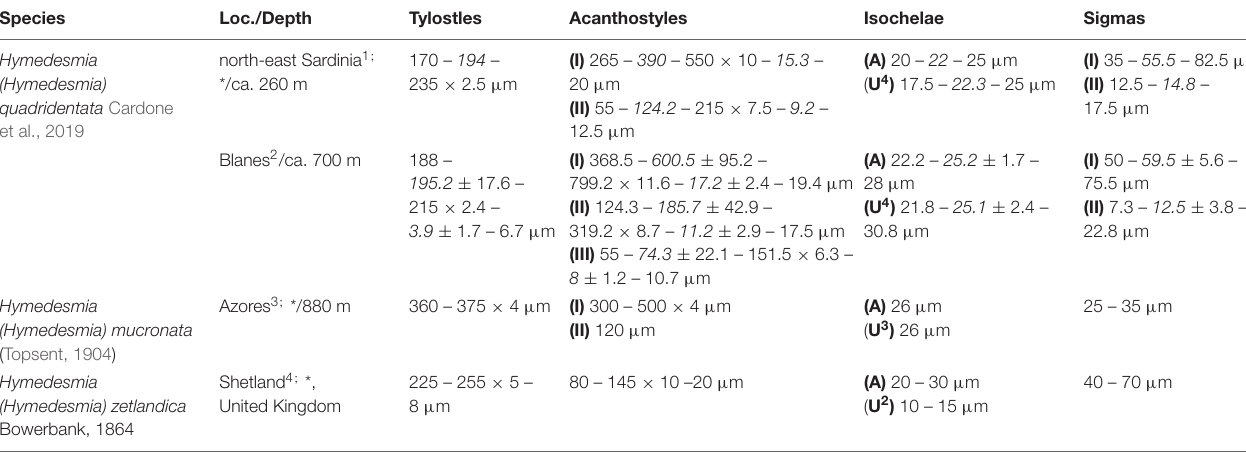
FIGURE 9 | Hymedesmia ( Hymedesmia ) quadridentata skeletal arrangement and spicular set. Left: Hymedesmoid skeleton, typical of the genus, with three acanthostyle categories (A1, A2, A3) erect on the substrate. Right: General view of H. ( H. ) quadridentata microscleres, including two categories of sigmas (SI and SII) and two categories of chelae (CI and CII), one of them with four unguliferous alae (CII). Scale bar 100 µ m. TABLE 5 | Comparative table between the North Atlantic Hymedesmia (Hymedesmia) species with unguliferous chelae, including the locality (Loc.) and depth of the sample, as well as the measurement of their spicular complement. Species Loc./Depth Tylostles Acanthostyles Isochelae